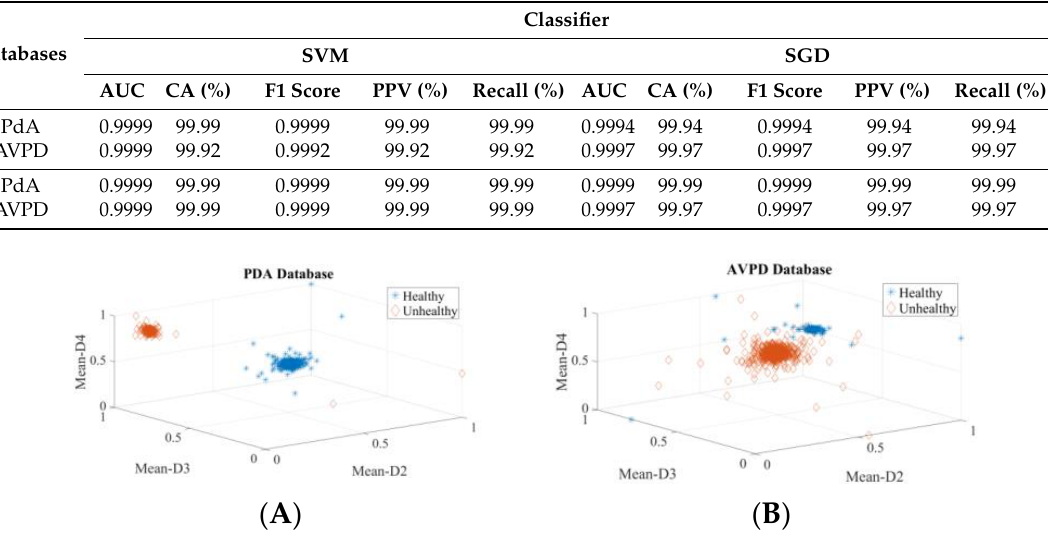
Table 12. Classifier performance measures for voice pathology identification for PdA and AVPD.